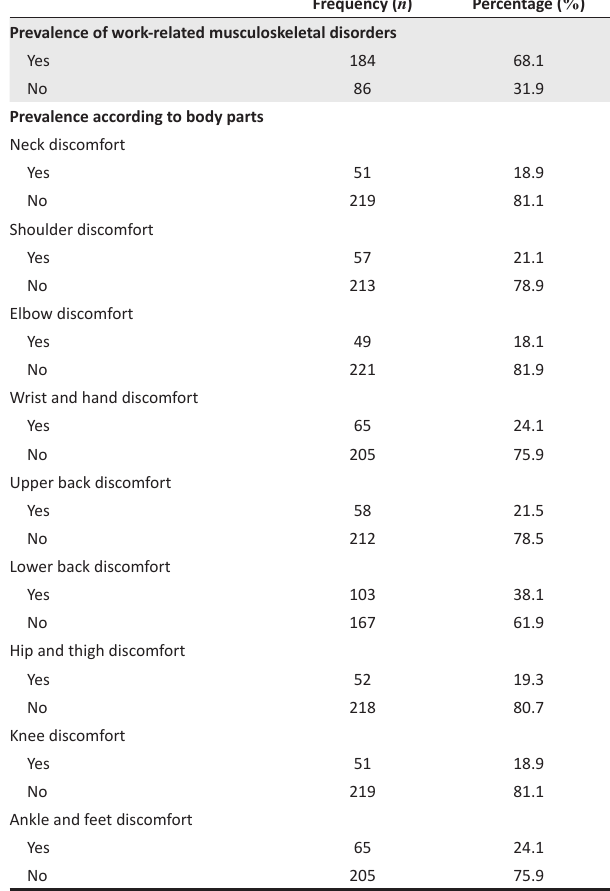
TABLE 1: Prevalence of musculoskeletal disorders according to body area ( n = 270). Frequency ( n ) Percentage ( % ) Prevalence of work-related musculoskeletal